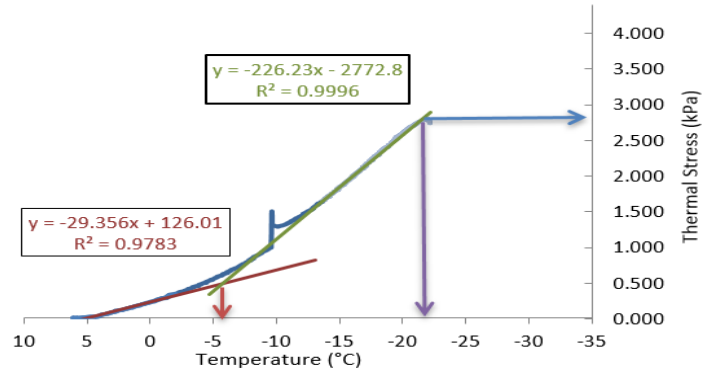
Figure 18. TSRST for coarse RAP (CR) mix.